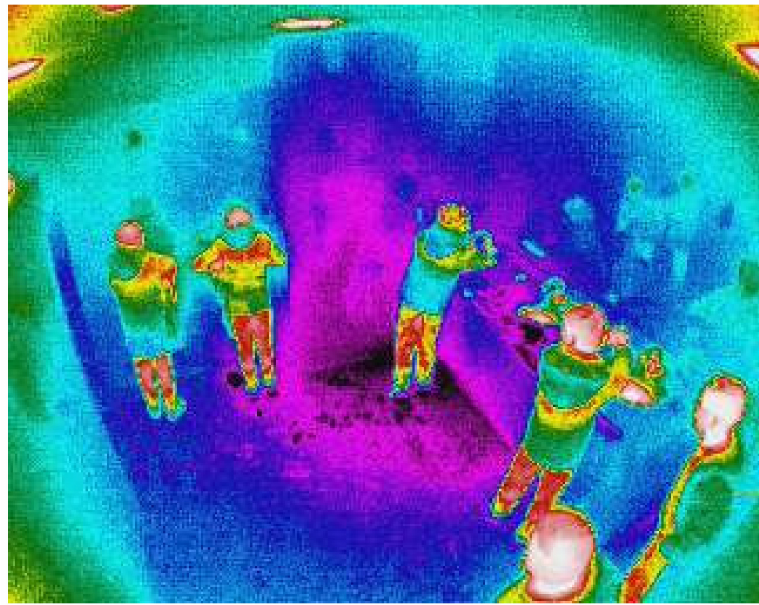
Figure 1. Infrared image of the male public restroom (wash-hand basin and hand dryer area